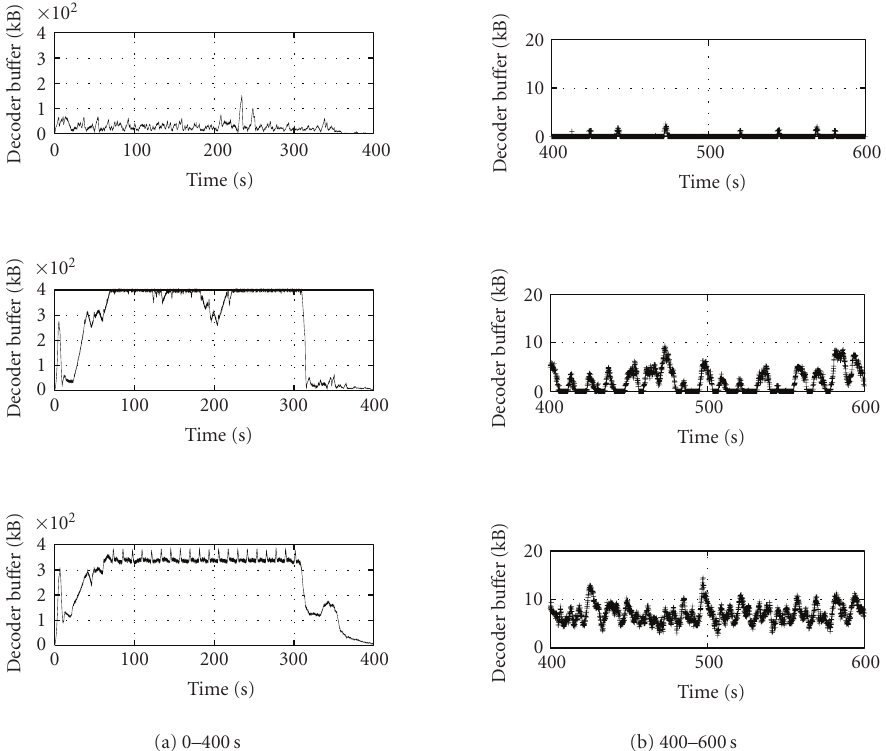
Figure 7: The decoder bu ff er occupancies of one GM-TFRC flow, one GM-ARC flow, and one VB-TFRCC-W flow; top: GM-TFRC, middle: GM-ARC, bottom: VB-TFRCC-W.